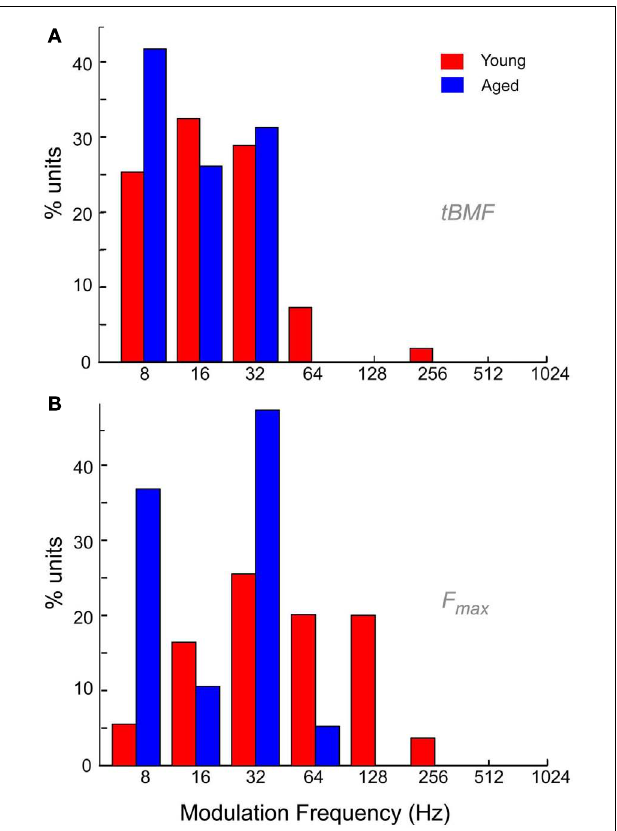
FIGURE 9 |Temporal characteristics of IC neurons from young and aged animals. (A) Distribution of best temporal modulation frequencies (tBMFs) in young (red) and aged (blue) animals among the recorded neurons in this study. Modulation frequency is marked along the X -axis in Hz and Y -axis indicates percentage of units with specified tBMF. (B) Distribution of temporal cut-off frequencies ( F max ) in young (red) and aged (blue) animals among the neurons recorded in this study. Axes same as (A)